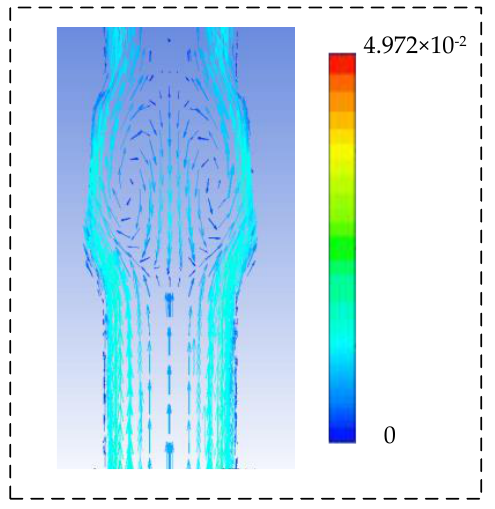
Figure 6. The flow line diagram of the SF 6 fluid in the multi-column arrester under monopole metal loop operation mode.